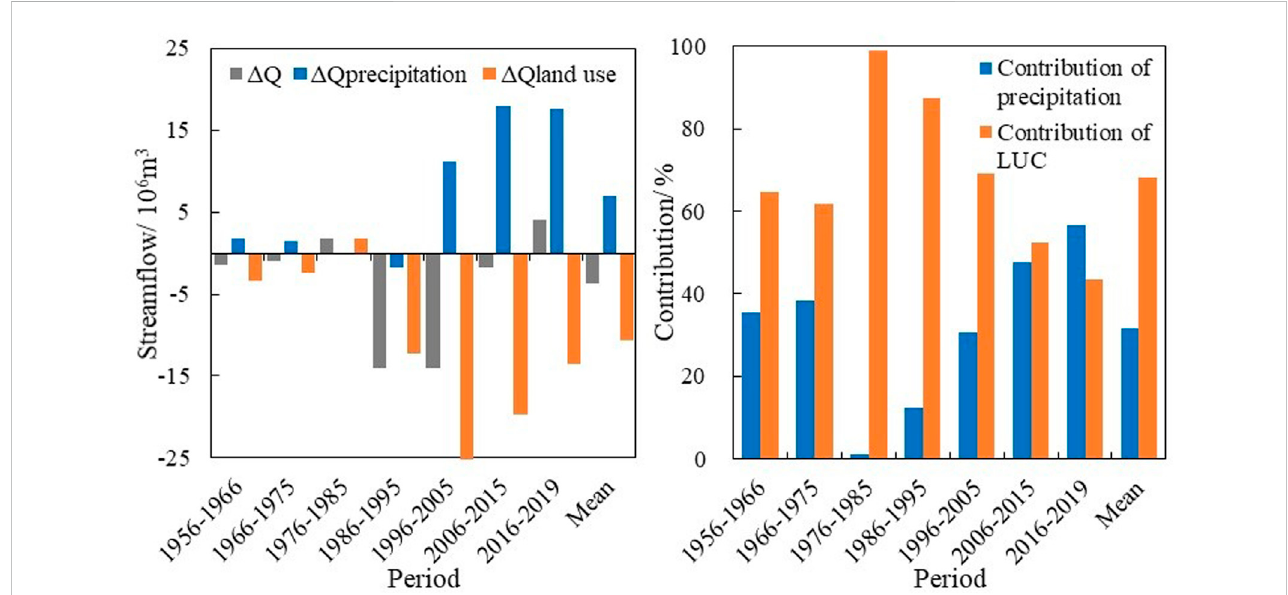
FIGURE 4 Stream fl ow difference before and after division point and contributions of land use change and precipitation change in various periods from 1956 to 2019intheMYC.( Δ Q isthestream fl owchangebasedonthecomparisonofbeforeandafterthedivisionpoint; Δ Q precipitation and Δ Q landuse arethestream fl ow changes caused by precipitation change and land use change, respectively).